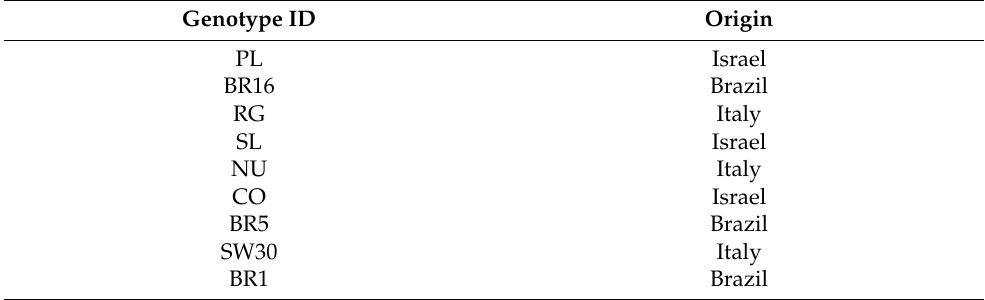
Table 1. Origin of S. rebaudiana genotypes.